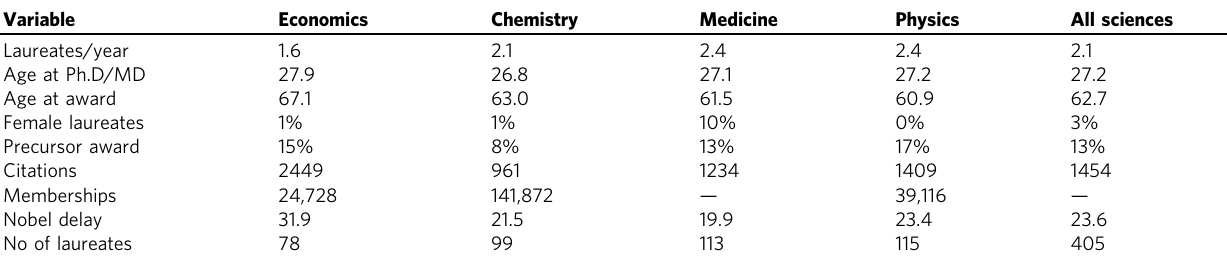
Table 3 Summary data for each variable by Nobel Prize discipline, averages between 1969 and 2016.